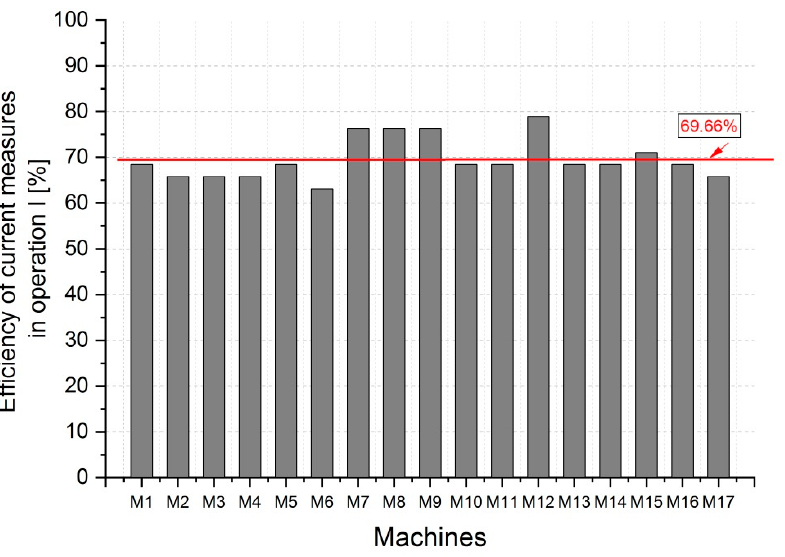
Figure 5. Total efficiency of current measures ∆ I in operation I [in %] (source: own design). Three criteria were analyzed and evaluated in a similar way (criteria, ∆ (cid:3038) , ∆ ) in two